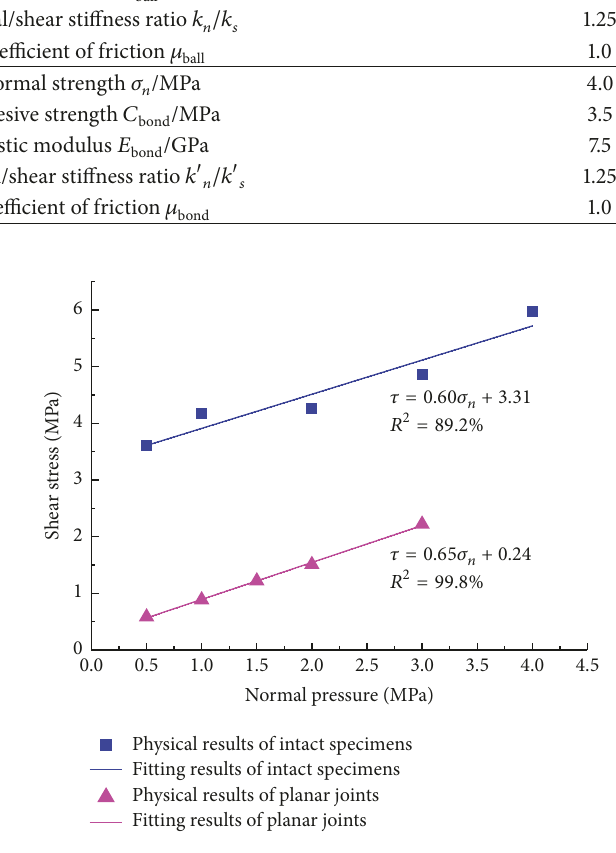
Figure 7: Results of the direct shear tests with intact specimens and jointed